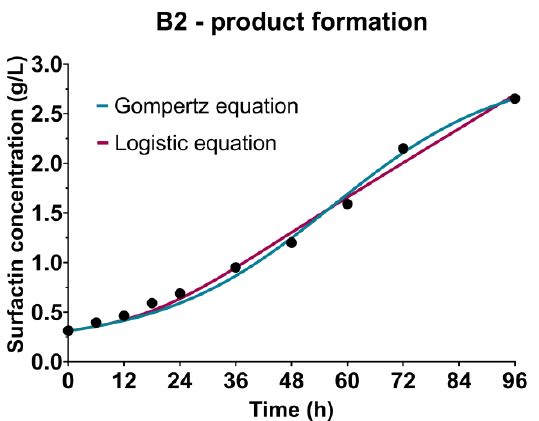
Figure 4. Bioprocess kinetics in terms of surfactin production during the Bacillus sp. BioSol021 cul- tivations in a 16 L bioreactor using the food industry effluents-based media: B1—cheese whey from dairy industry, B2—winery flotation wastewater.